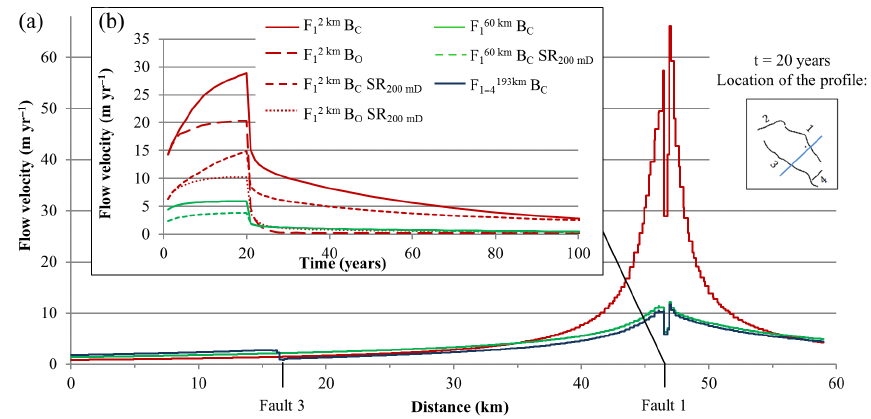
Figure 6. (a) Velocity profile within the lower element layer of the shallow aquifer shows the highest flow velocities out of Fault 1 at the end of injection period. (b) Flow velocities out of Fault 1 increase until the end of the injection period (20 years) and decrease afterwards depending on pressure reduction of the respective